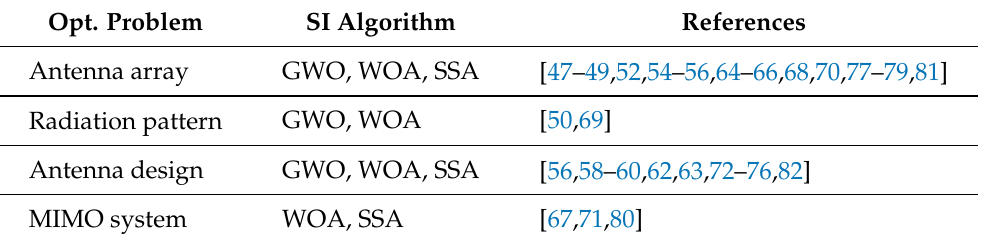
Table 1. Summary of optimization problems and the corresponding algorithms. Opt.